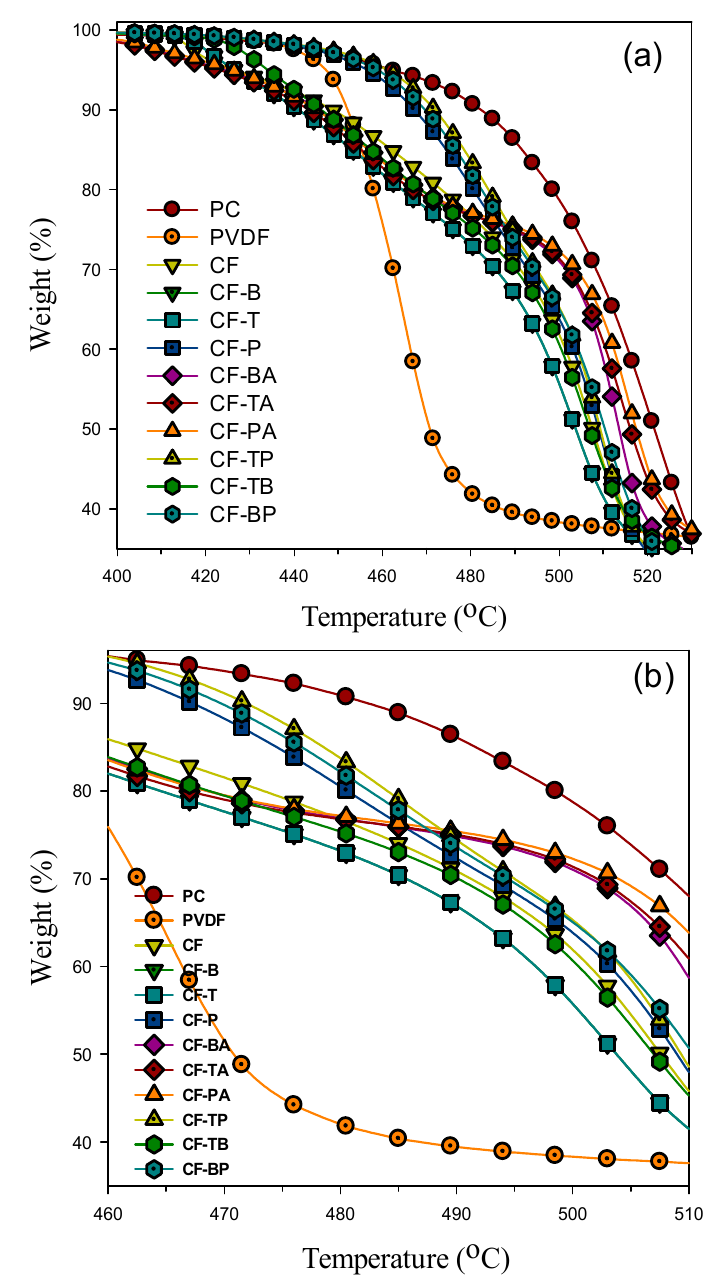
Figure 6. TGA curves of tested samples plotted under a different temperature range for ( a ) and ( b